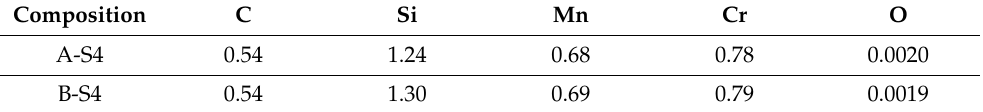
Table 3. Measured chemical composition of S4 samples in different